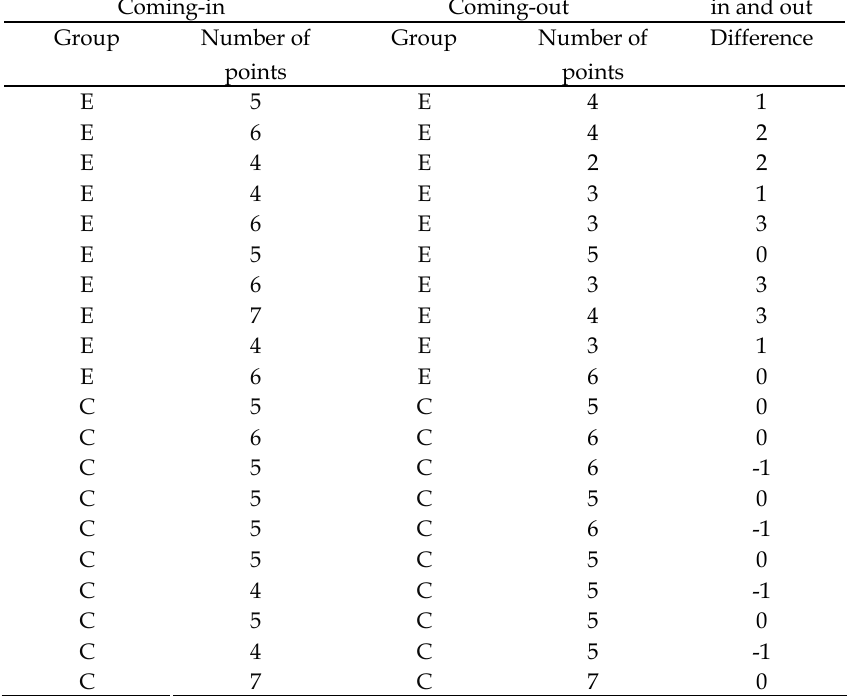
Table 1. Questionnaire of changed seniors’ abilities - difference between in and out testing.